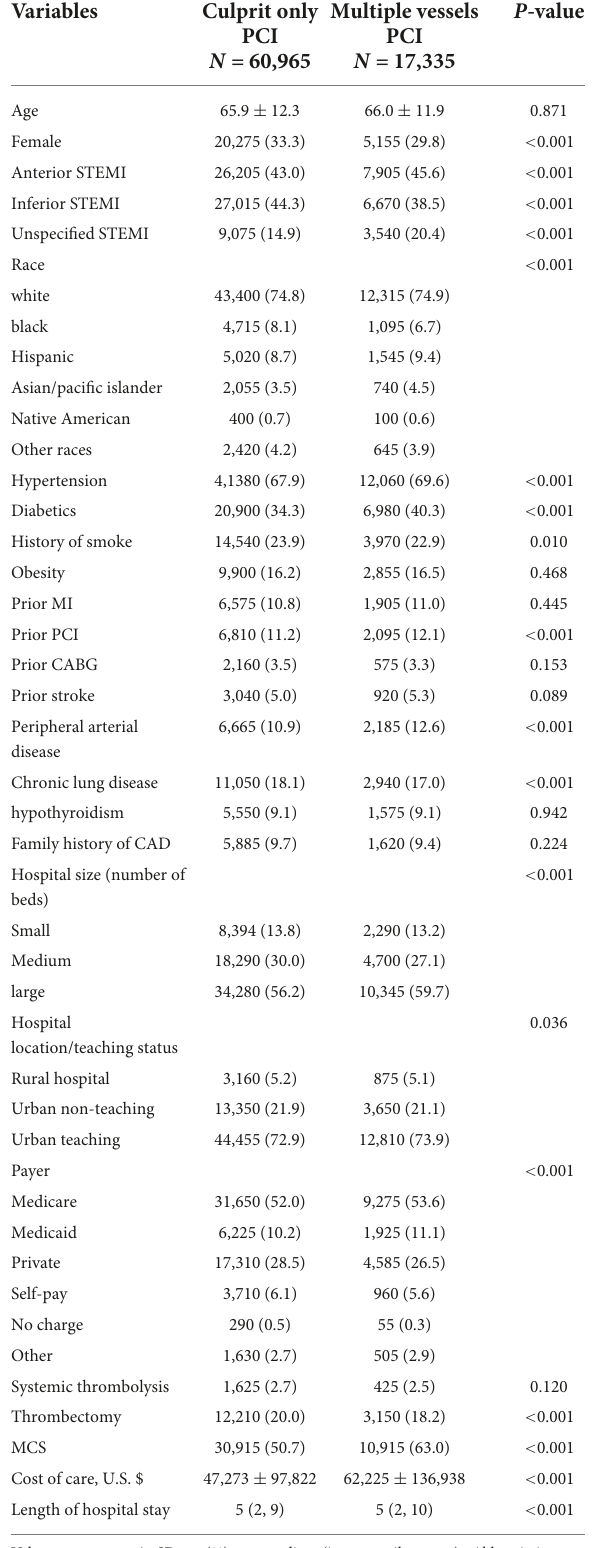
TABLE 3 Baseline characteristics in STEMI hospitalizations with cardiogenic